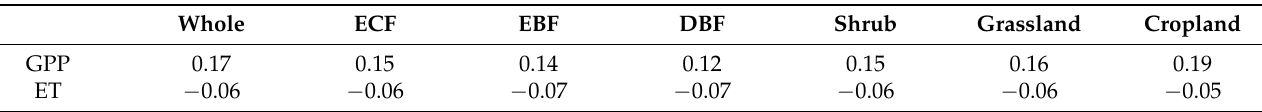
Table 1. Ridge regression coefficients of GPP and ET for the annual WUE trends for different land- scapes in subtropical China.